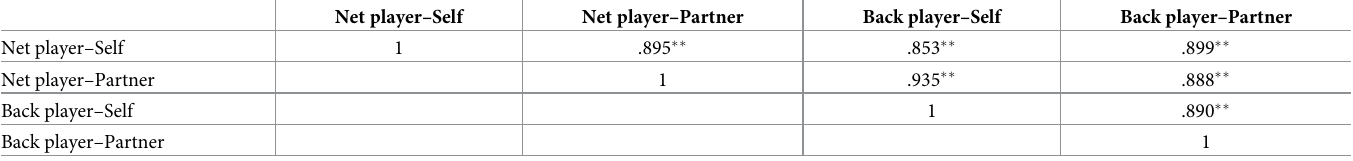
Table 2. Correlational table across the four